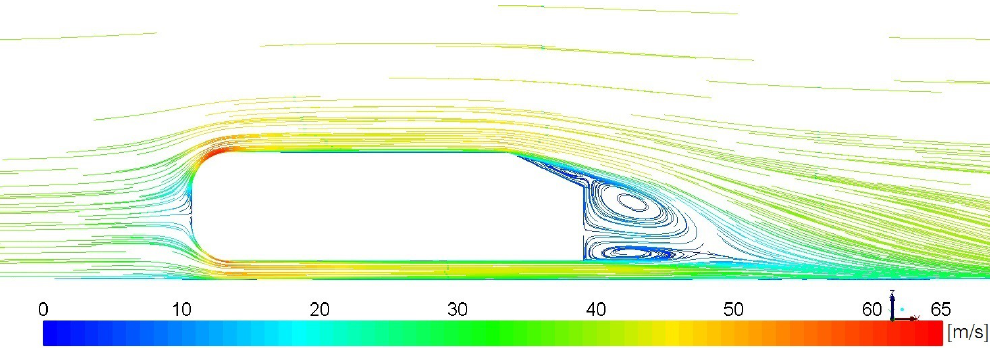
Figure 6. Streamlines around the Ahmed body at symmetry plane.